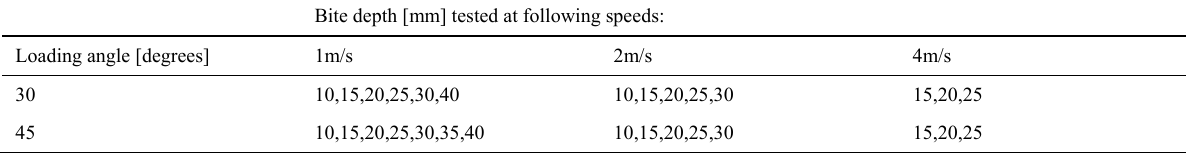
Fig. 3 Joint test setup. Table 1: Test matrix showing the angle and speeds at which the different bite depths were